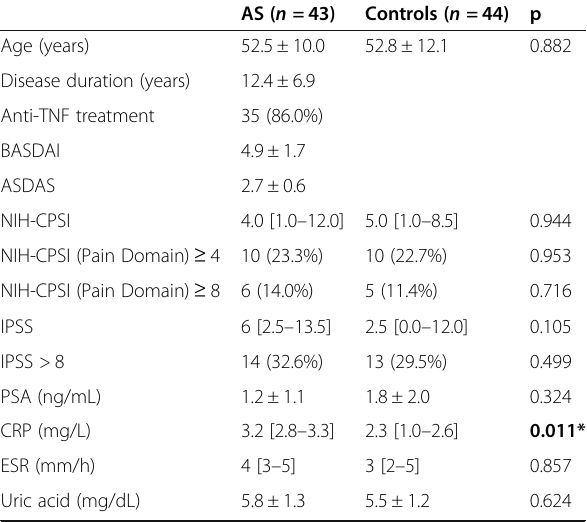
Table 1 Clinical characteristics and blood laboratory tests of AS patients and controls (excluding participants with positive urinary cultures - two in the AS group and one in the control group) AS ( n =